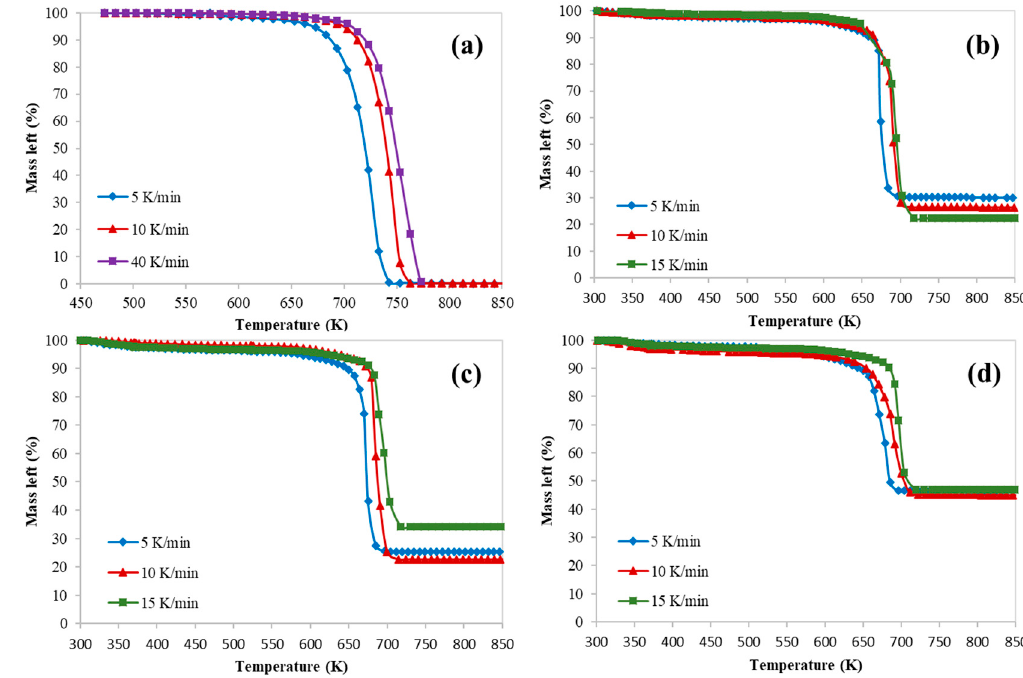
Figure 1. Thermogravimetric analysis (TGA) curves of catalytic pyrolysis of HDPE at different catalyst to polymer mass ratio: ( a ) 0, ( b ) 0.5, ( c ) 0.77, and ( d ) 1.